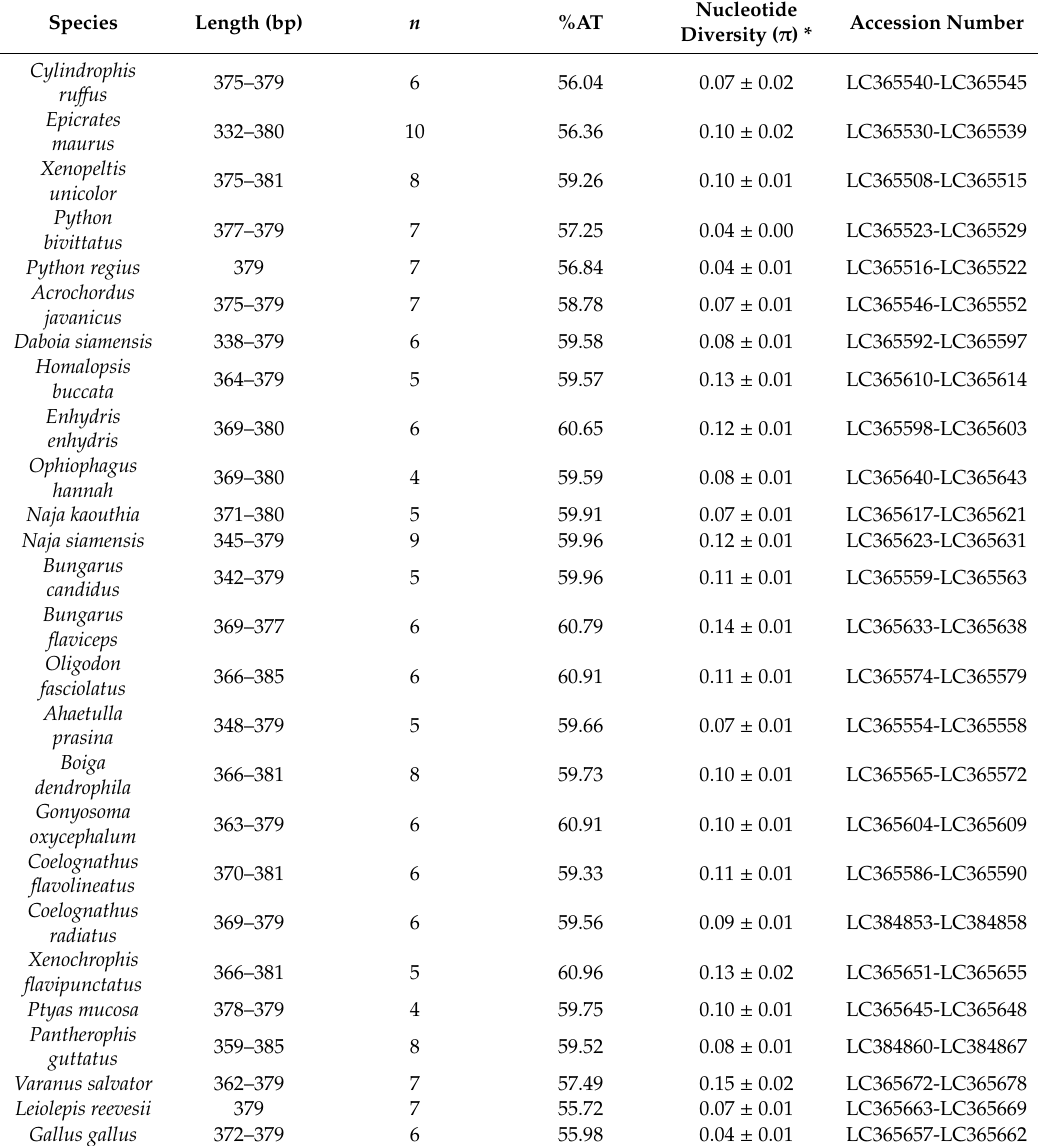
Table 3. Summary of nucleotide diversity ( π ) for each species used in this